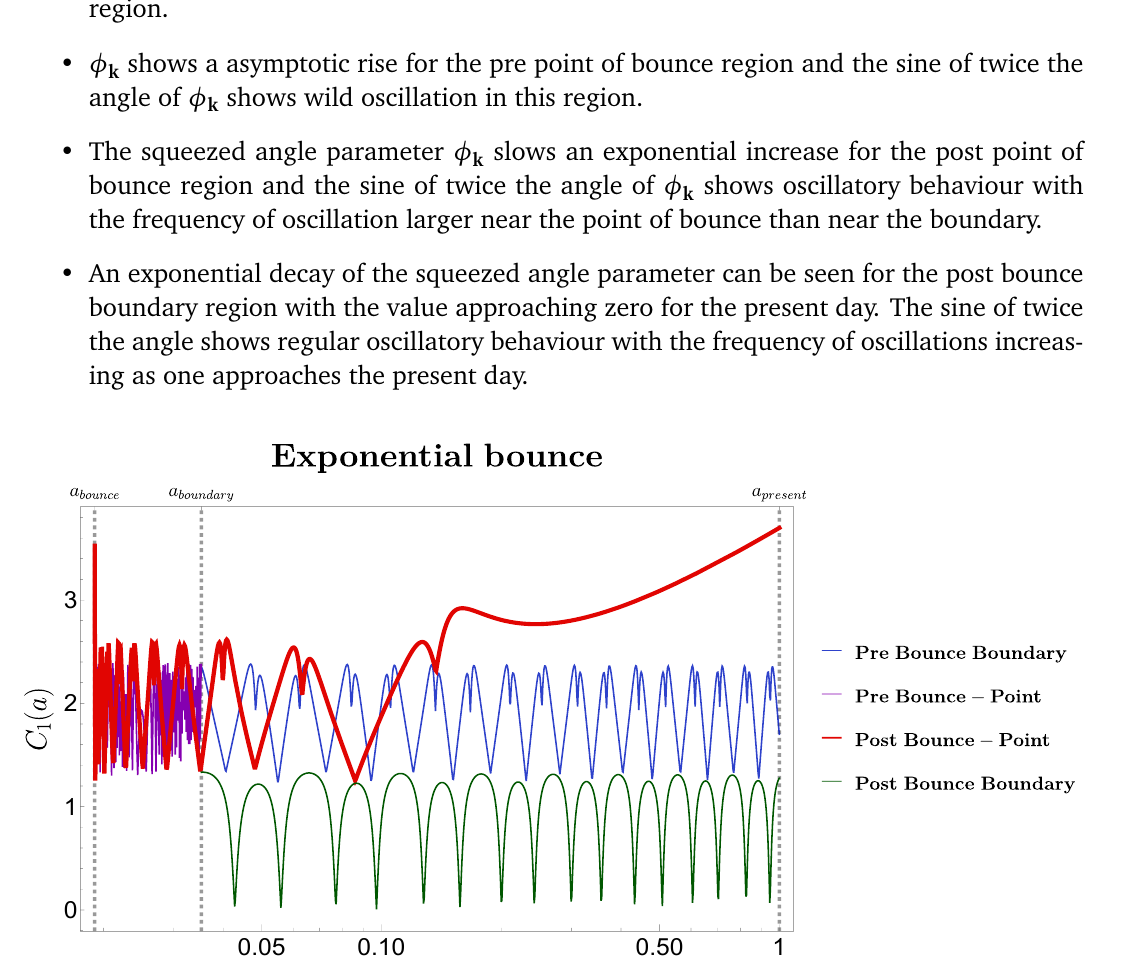
and have been plotted with C 1 C 2